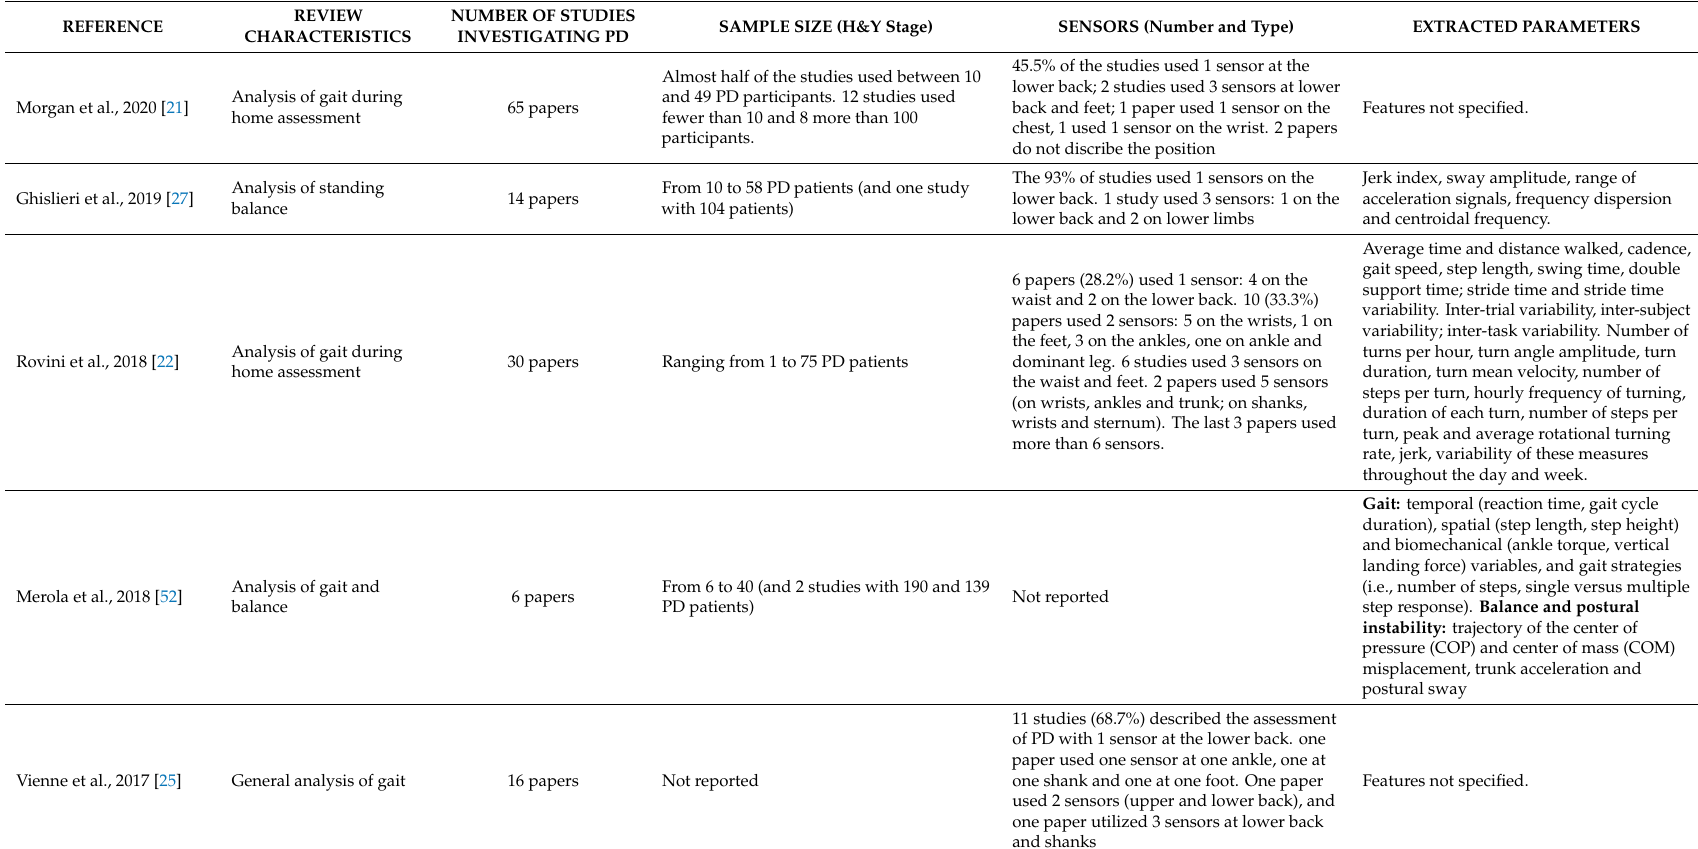
Table 1. Summary of the major characteristics of the PD reviews that met the inclusion